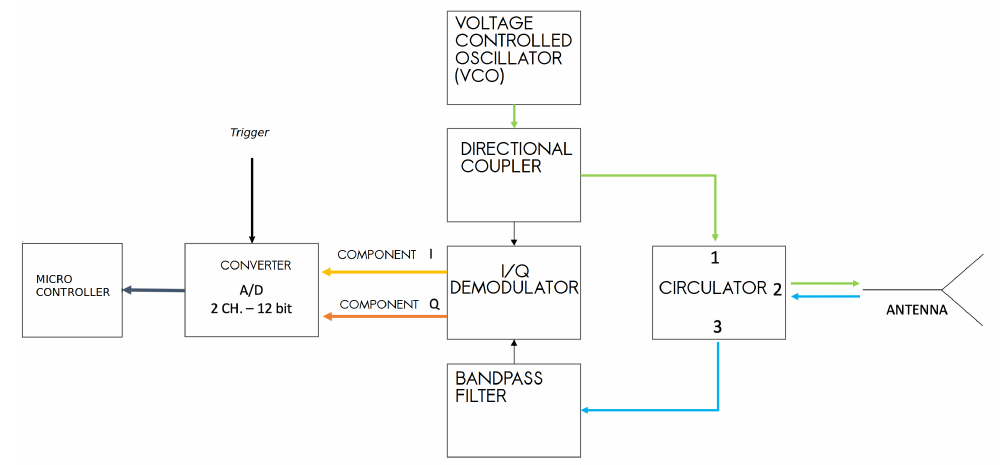
Figure 3. Block diagram of the electronics for a microwave processing the signal of a MW